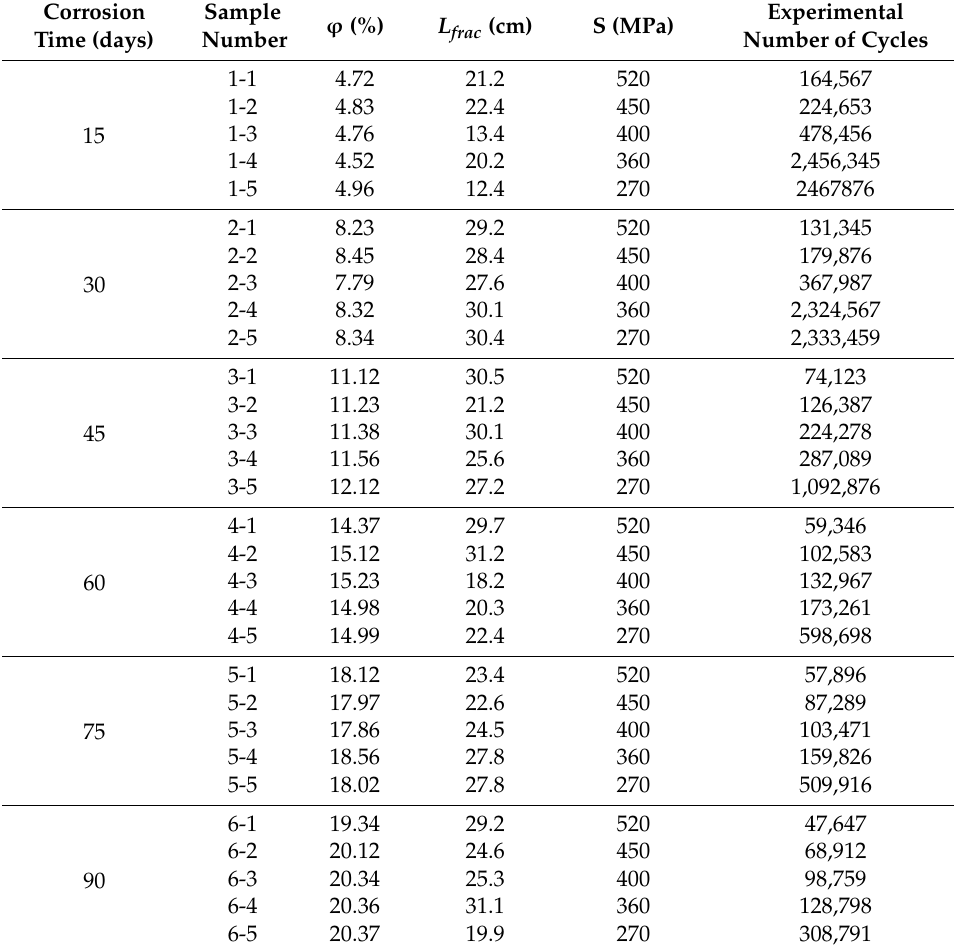
Table 3. Corrosion fatigue test results.